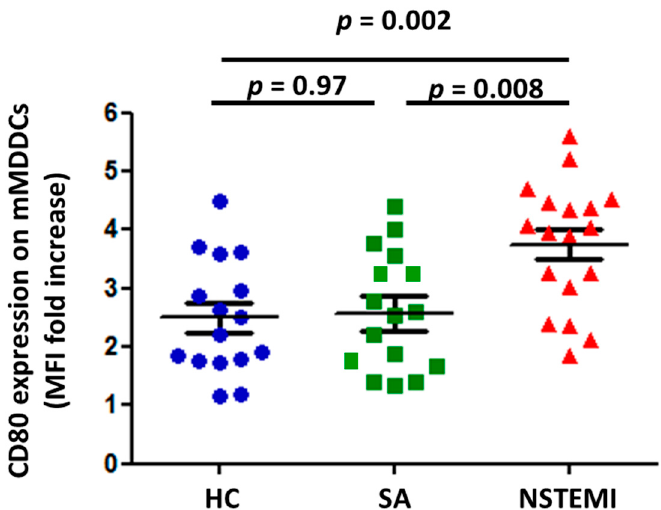
Figure 1. Altered monocytes derived dendritic cells (MDDC) maturation in non-ST segment elevation myocardial infarction (NSTEMI) patients. Monocytes from 18 NSTEMI, 16 SA and 16 HC were differentiated in vitro for 6 days to generate immature MDDCs (iMDDCs). For MDDCs activation (mMDDCs), iMDDCs were exposed to 1 ng/mL LPS for 24 h (Figure S1). CD80 expression on mMDDCs was higher in NSTEMI patients compared with SA and HC ( p for trend = 0.003). Data are presented as single dot plots and means ± SEM of MFI fold increased respect to iMDDCs. MDDCs = myeloid derived dendritic cells; SEM = standard error of mean; MFI = mean fluorescence intensity.